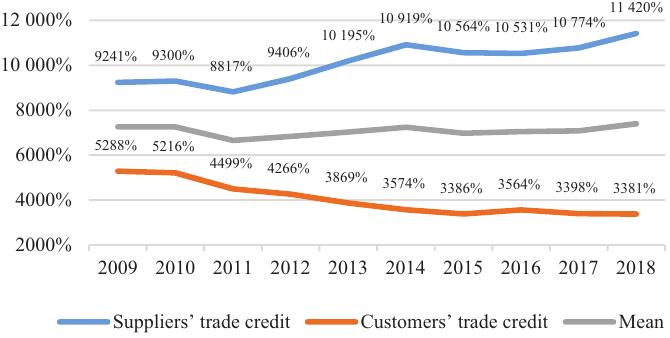
Figure 1. A line graph demonstrates suppliers’ trade credit and customers’ trade-credit annual trends of Chinese firms from 2009 to